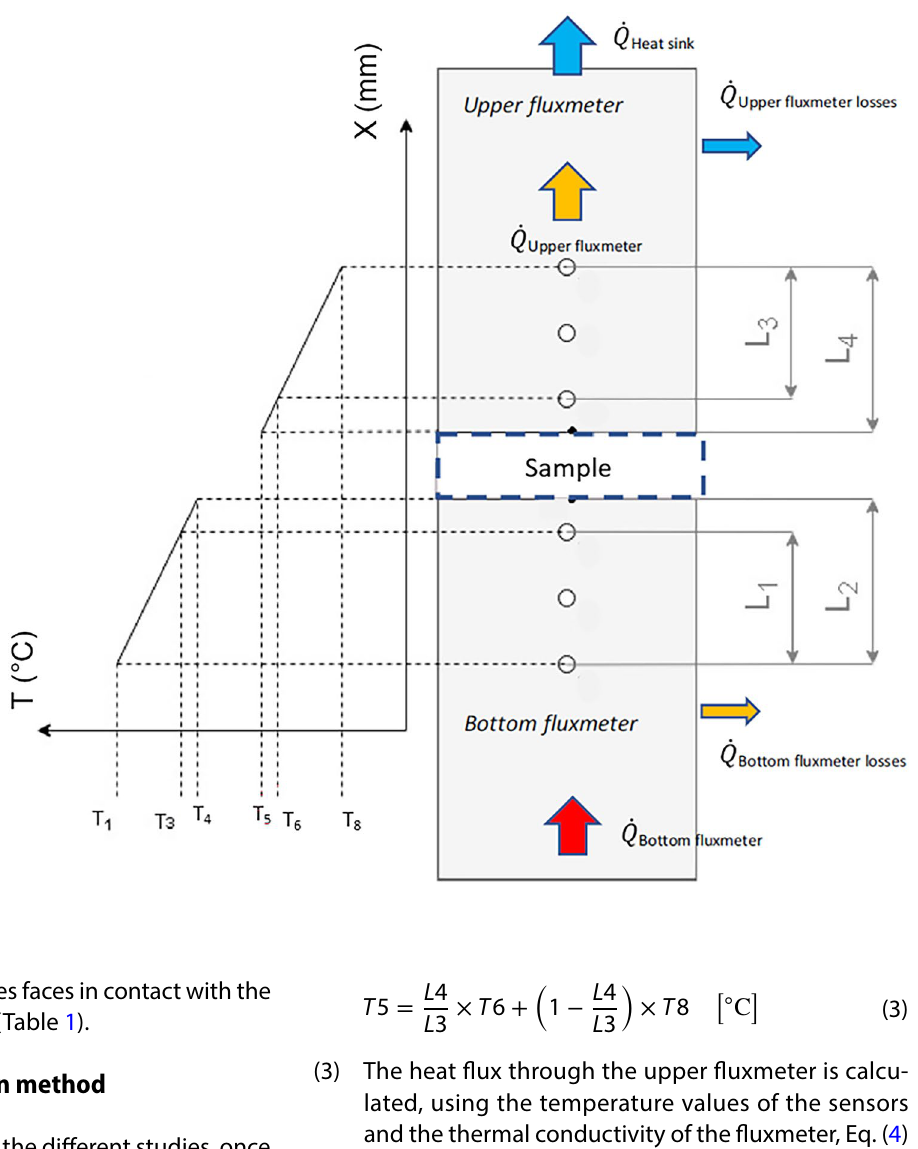
Fig. 5 Distance between ther- mocouples and temperature drop in